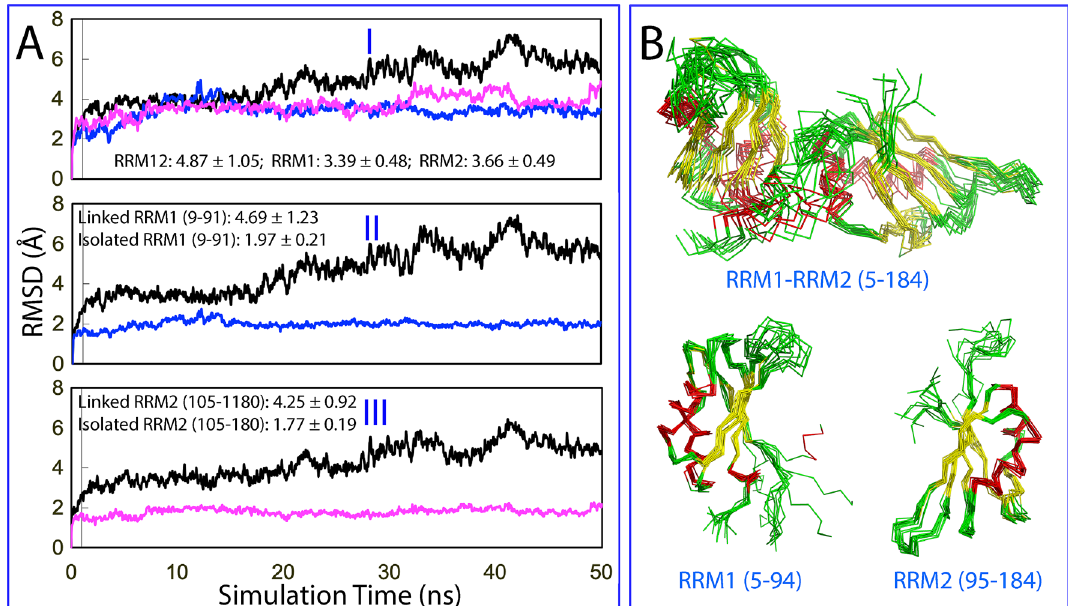
Figure 8. Overall dynamic behaviors of the hnRNPA1 RRM domains. ( A ) Average root-mean-square deviations (RMSD) of the Cα atoms over three independent 50-ns MD simulations for the tethered RRM1– RRM2 (black), as well as isolated RRM1 (blue) and RRM2 (pink) (I). for the RRM1 in the tethered form (black) and isolated form (blue) with the unstructured N- and C-termini excluded for calculation (II); as well as for the RRM2 in the tethered form (black) and isolated form (pink) with the unstructured N- and C-termini excluded for calculation (III). ( B ) Structure snapshots in the first MD simulation with one structure for each 5 ns. The image was prepared by PyMol2.4 (https ://pymol